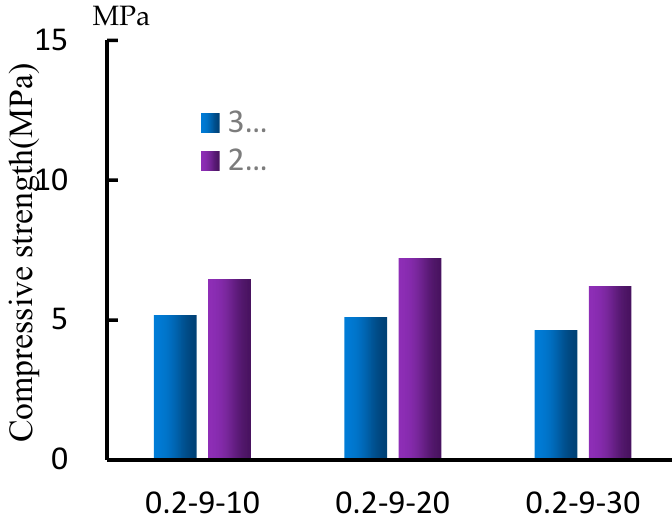
Figure 3. Compressive strength as a function of rubber content.